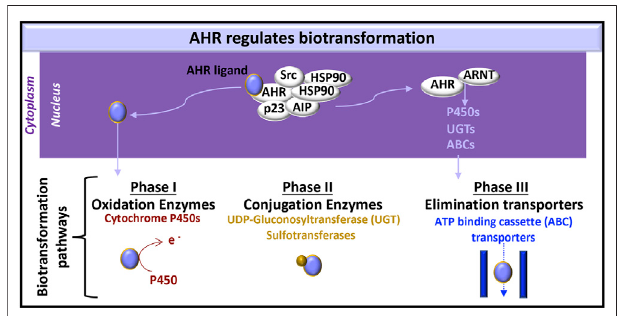
FIGURE 2 | AHR-initiated biotransformation. AHR induces the transcriptionofcertaingeneswhoseproductsareinvolvedineachofthethree phases of drug